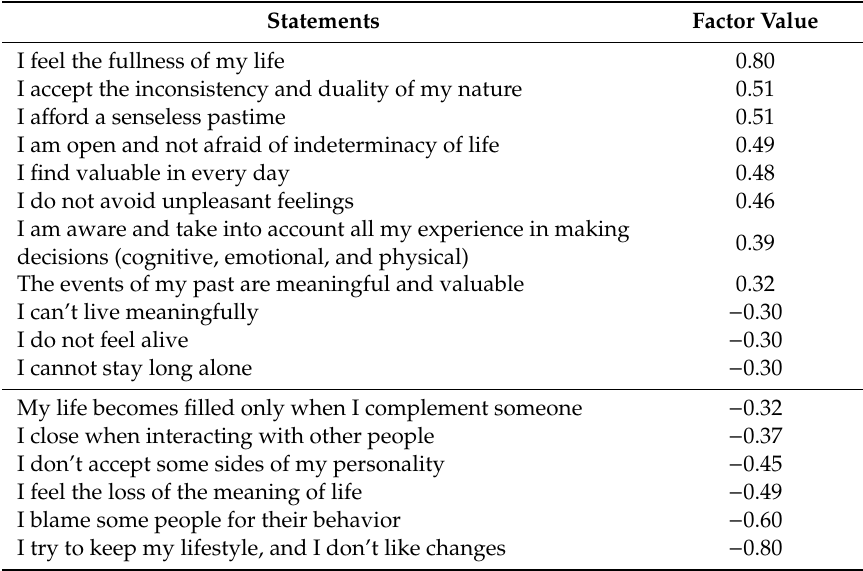
Table 5. Factor “Values and Personal Meanings”.